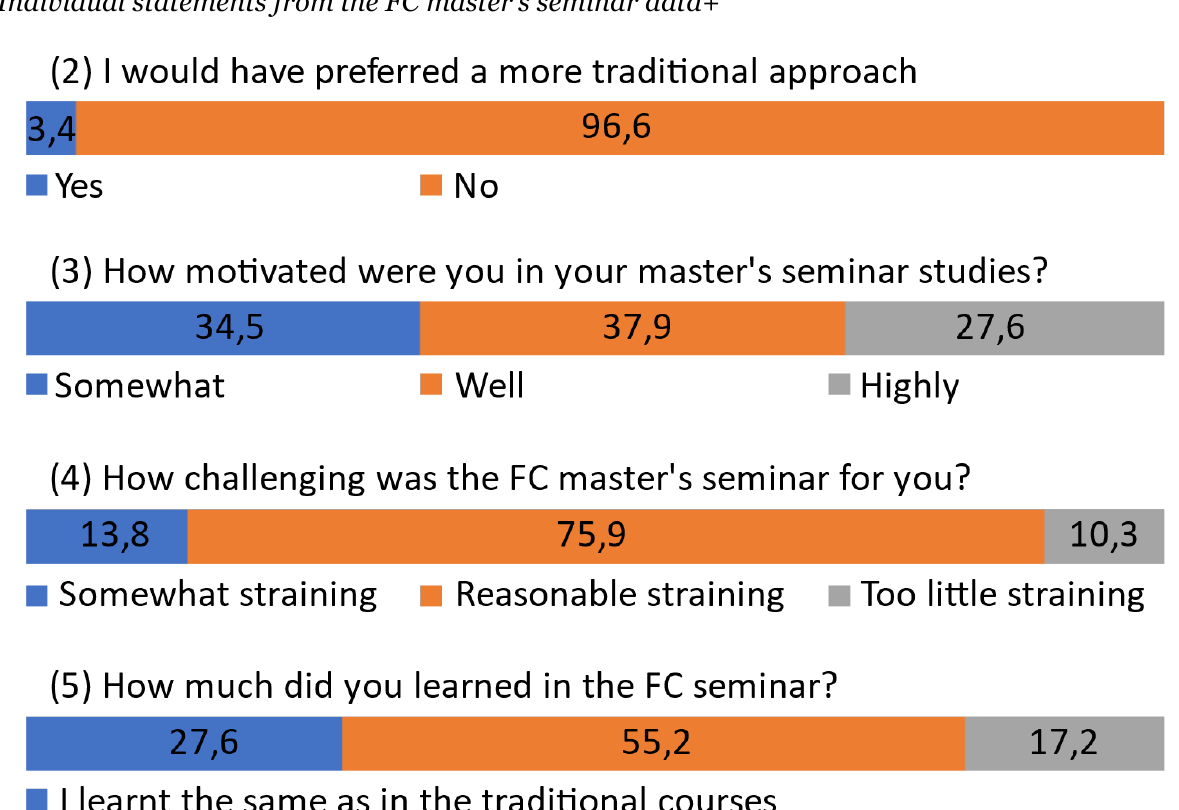
Individual statements from the FC master’s seminar